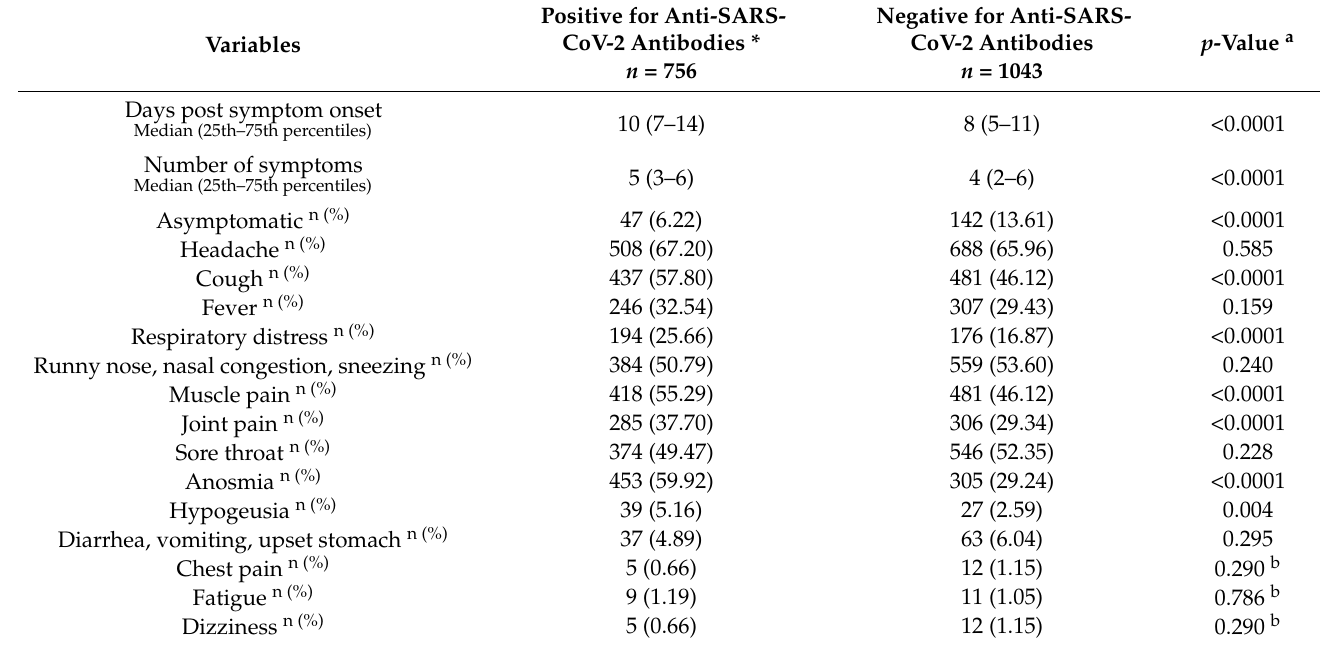
Table 2. Symptoms of individuals negative or positive for anti-SARS-CoV-2